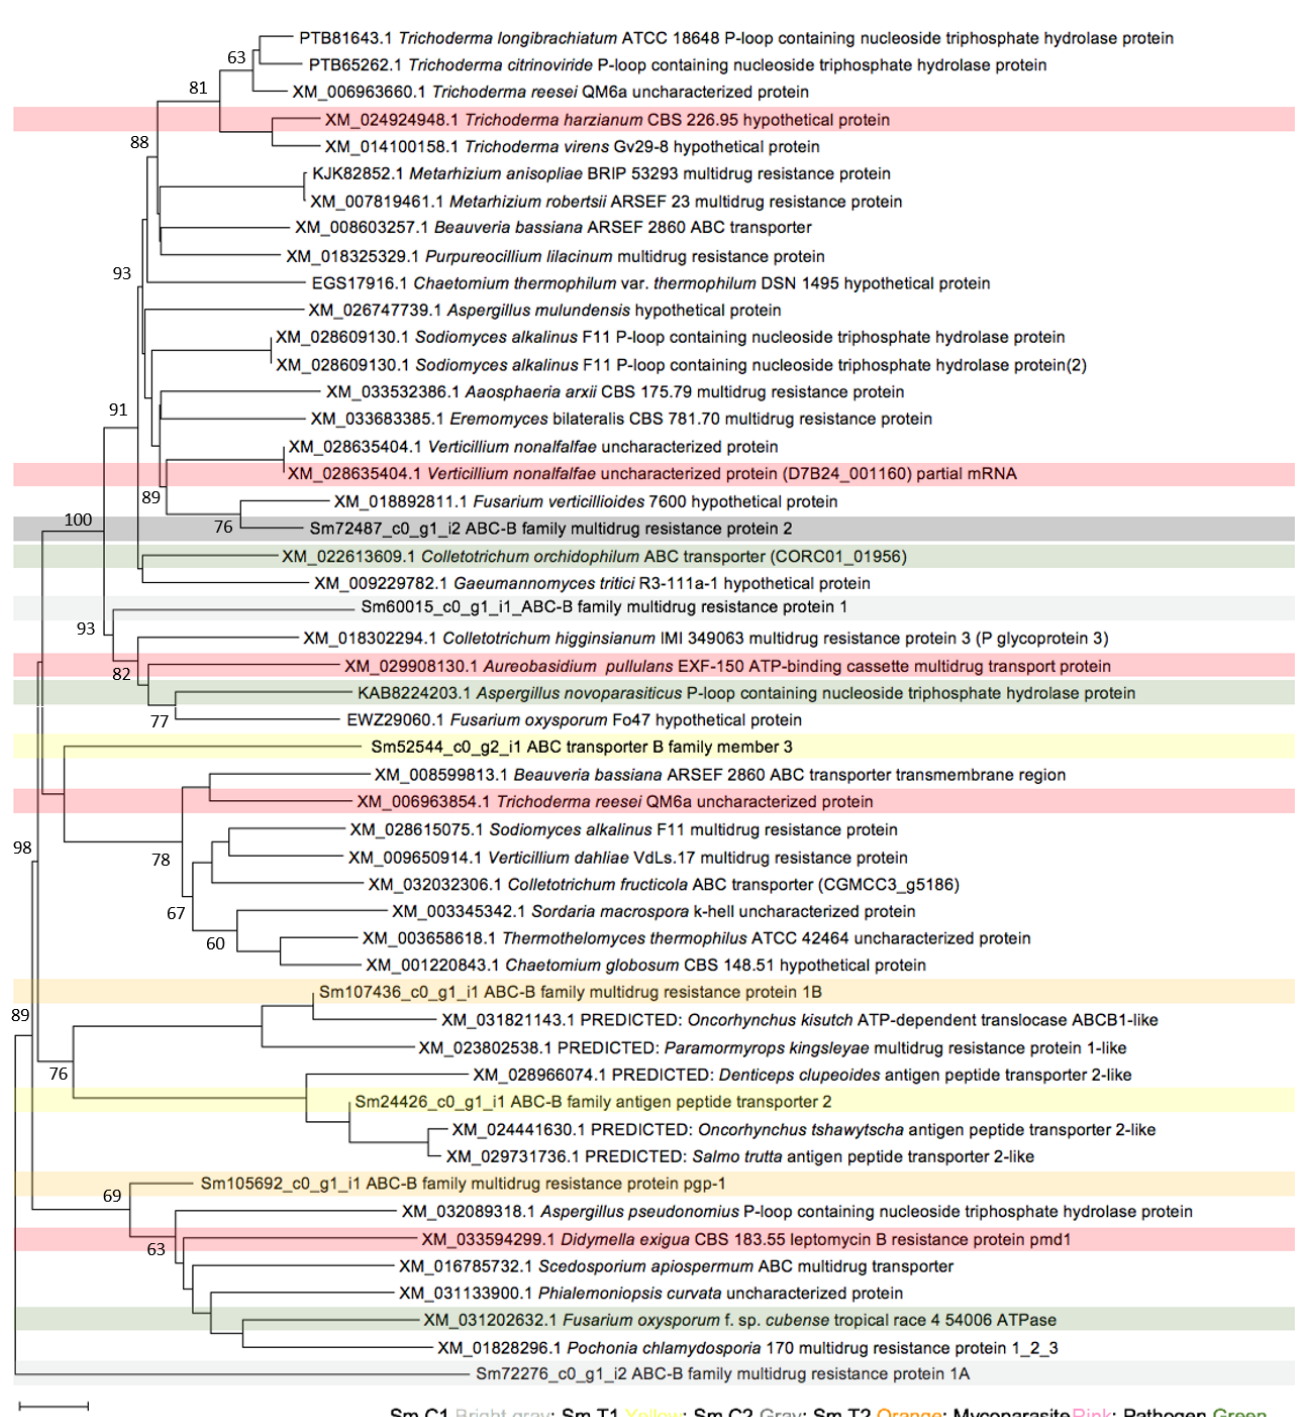
Figure 5. The unrooted phylogenetic tree for the ABC-B family transporters in S. mycoparasitica was built with MEGA-X by using the minimum evolution method [39]. The branch support bootstrap (>60%) values were obtained by 1000 replicates using the NJ method. Sm C1 (bright gray color) and Sm C2 (gray color) represent S. mycoparasitica incubated for 1.5 and 3.5 days, respectively, without interaction with the host, whereas Sm T1 (yellow color) and Sm T2 (orange color) represent S. mycoparasitica interacting with the host for respective incubation times (1.5 and 3.5 days). The mycoparasite and the pathogen were highlighted in red and green colors,